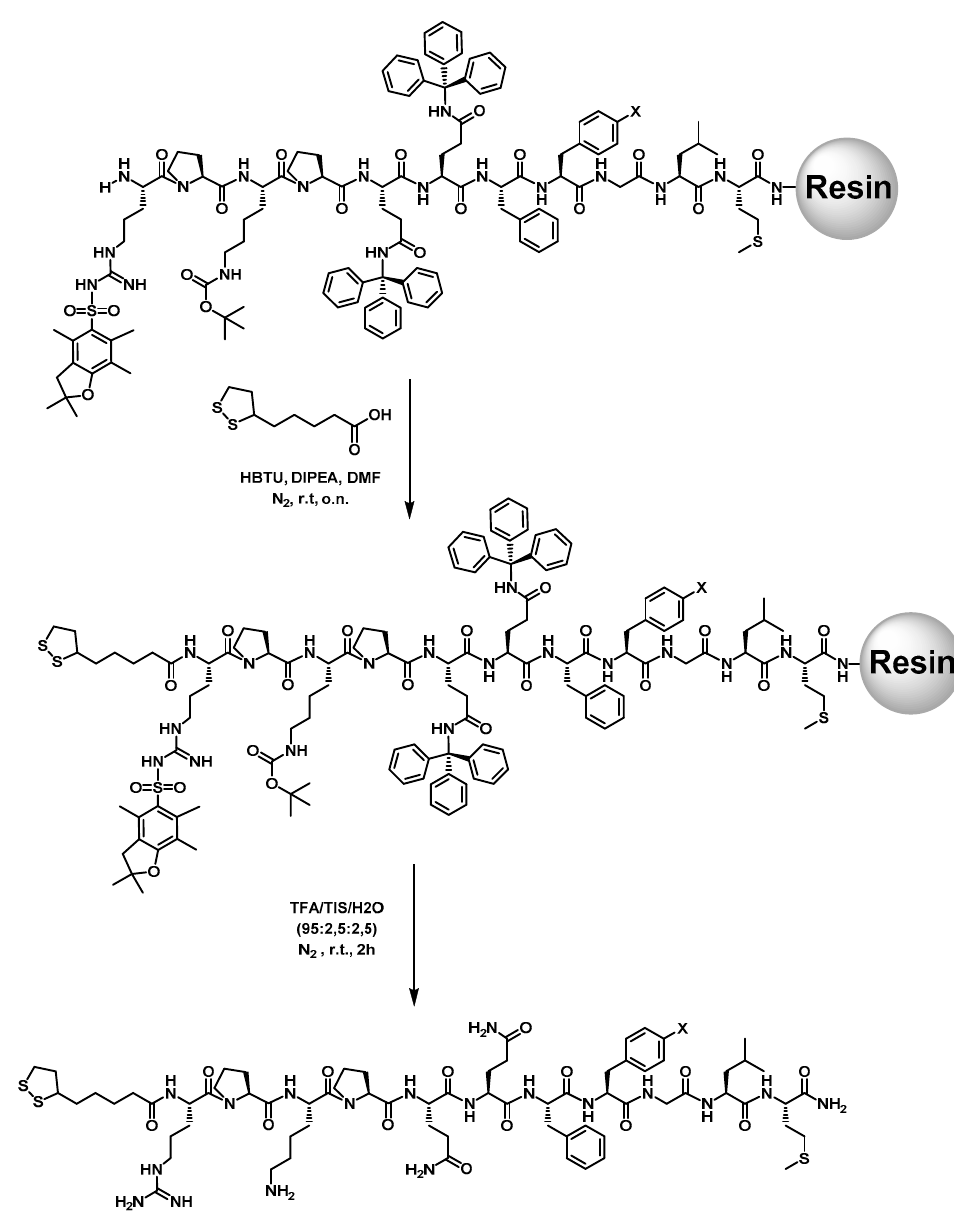
Scheme 1. Synthetic route towards the TA-SP (X = H) and TA-SPTyr8 (X = OH)